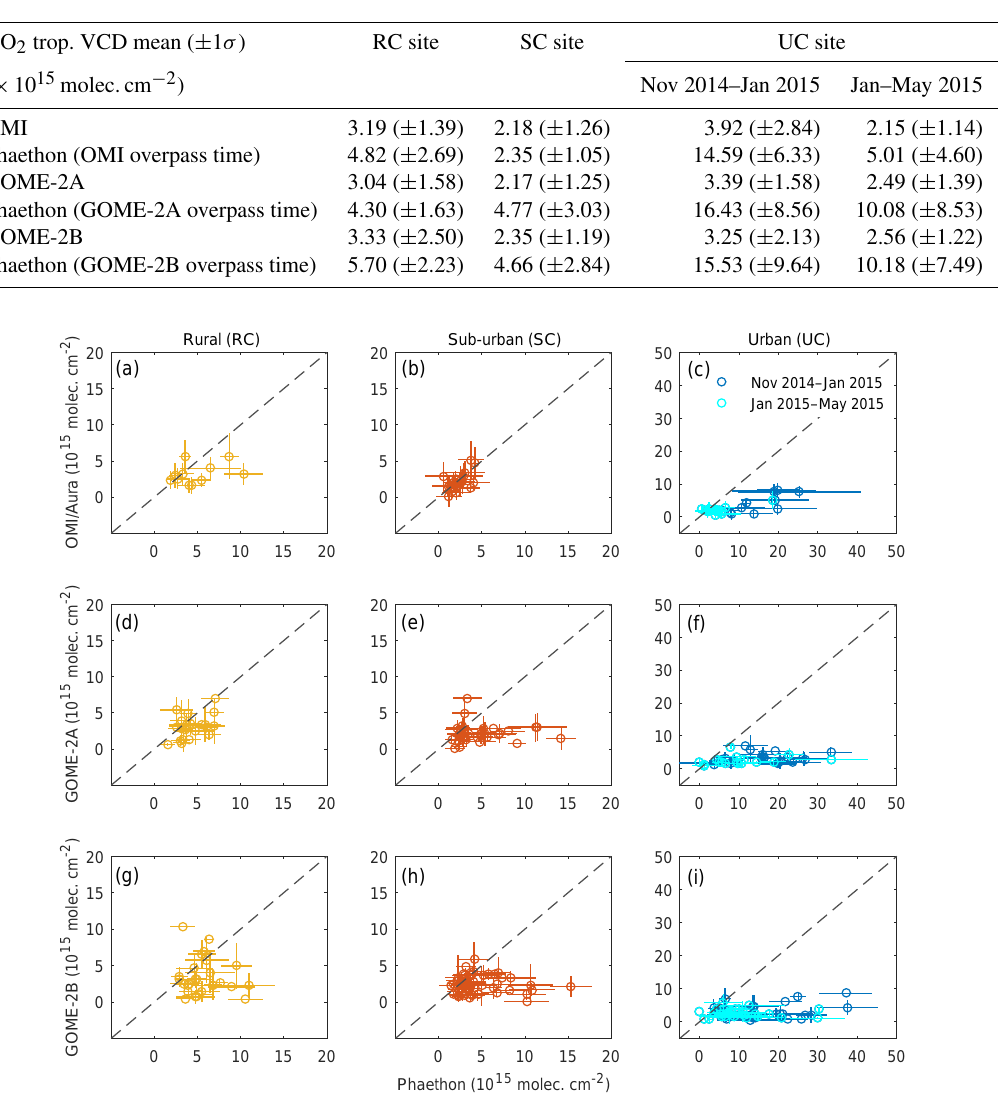
Figure 8. Scatterplots of tropospheric NO 2 VCD derived from the ground and space for each campaign site: RC (a, d, g) , SC (b, e, h) and UC (c, f, i) ; and satellite sensor: OMI (a, b, c) , GOME-2A (d, e, f) and GOME-2B (g, h, i) . The NO 2 measurements at the UC site are separated into two periods: from November 2014 to the end of January 2015 (blue circles) and from mid-January to mid-May 2015 (light blue circles). Error bars are the standard deviation of all data points entering the mean for the ground-based data and the estimated total error for the satellite overpass data. Note the different scale for the UC site. Statistics of the comparisons can be found in Tables 4 and 5.